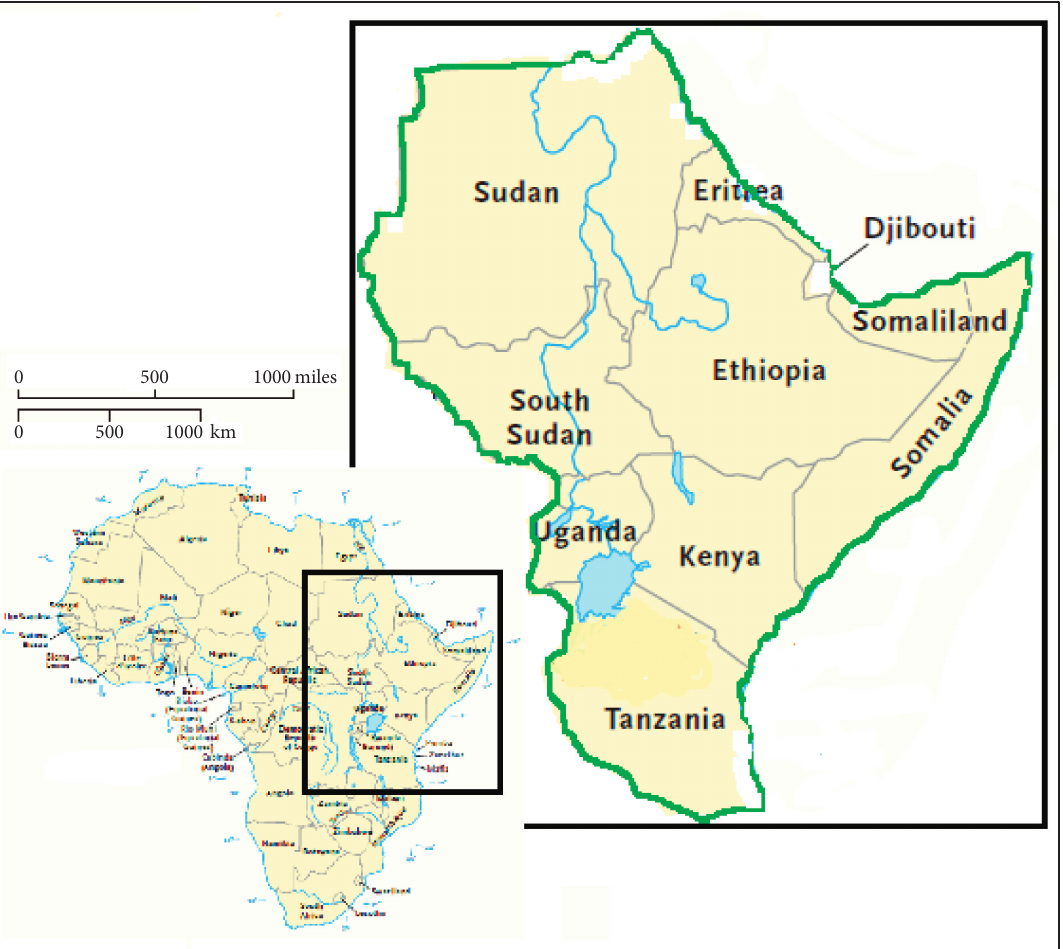
Figure 1: A geographical map for countries of Eastern Africa included in the present